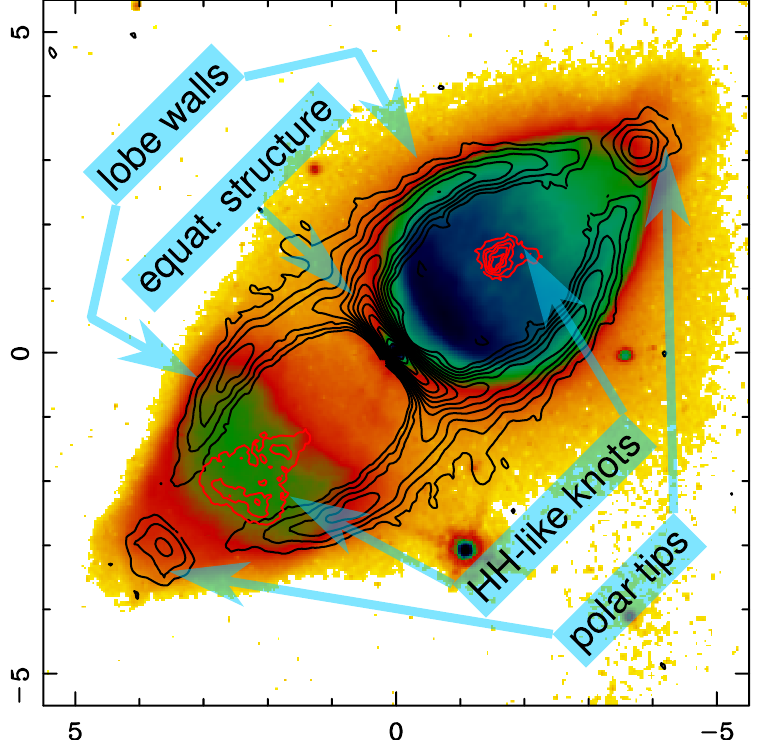
Figure 1. Composition of observations of M1–92 depicting the main components of the nebula. The colour image is the continuum reflected light at 5970Å, while the red contours show the HH-like knots as seen in [SII] (both images are from HST-WFPC2 observations by Bujarrabal et al. [7]). Black contours show the emission of 13 CO J = 2–1 but just for the plane containing the symmetry axis of the nebula (obtained from data by Alcolea, Neri, Bujarrabal [10] after a 3D-image reconstruction process similar to that described in Section 3). Here and in the rest of the figures, the spatial units are east and north offsets in